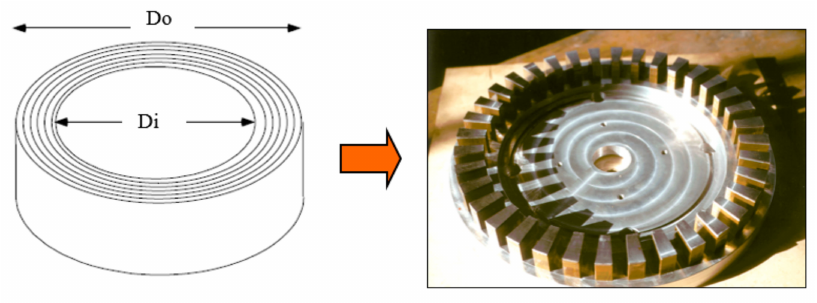
Figure 3. The prototype of a laminated stator